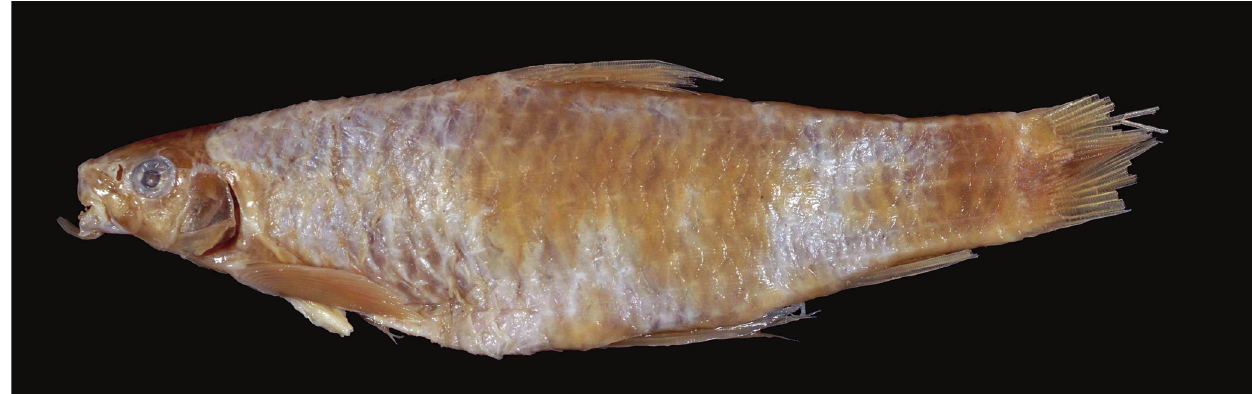
Fig. 10. Parodon suborbitalis , Lectotype, MNHN 1807, 97 mm SL, Venezuela, Lake Maracaibo basin (Photo by Romain Causse,